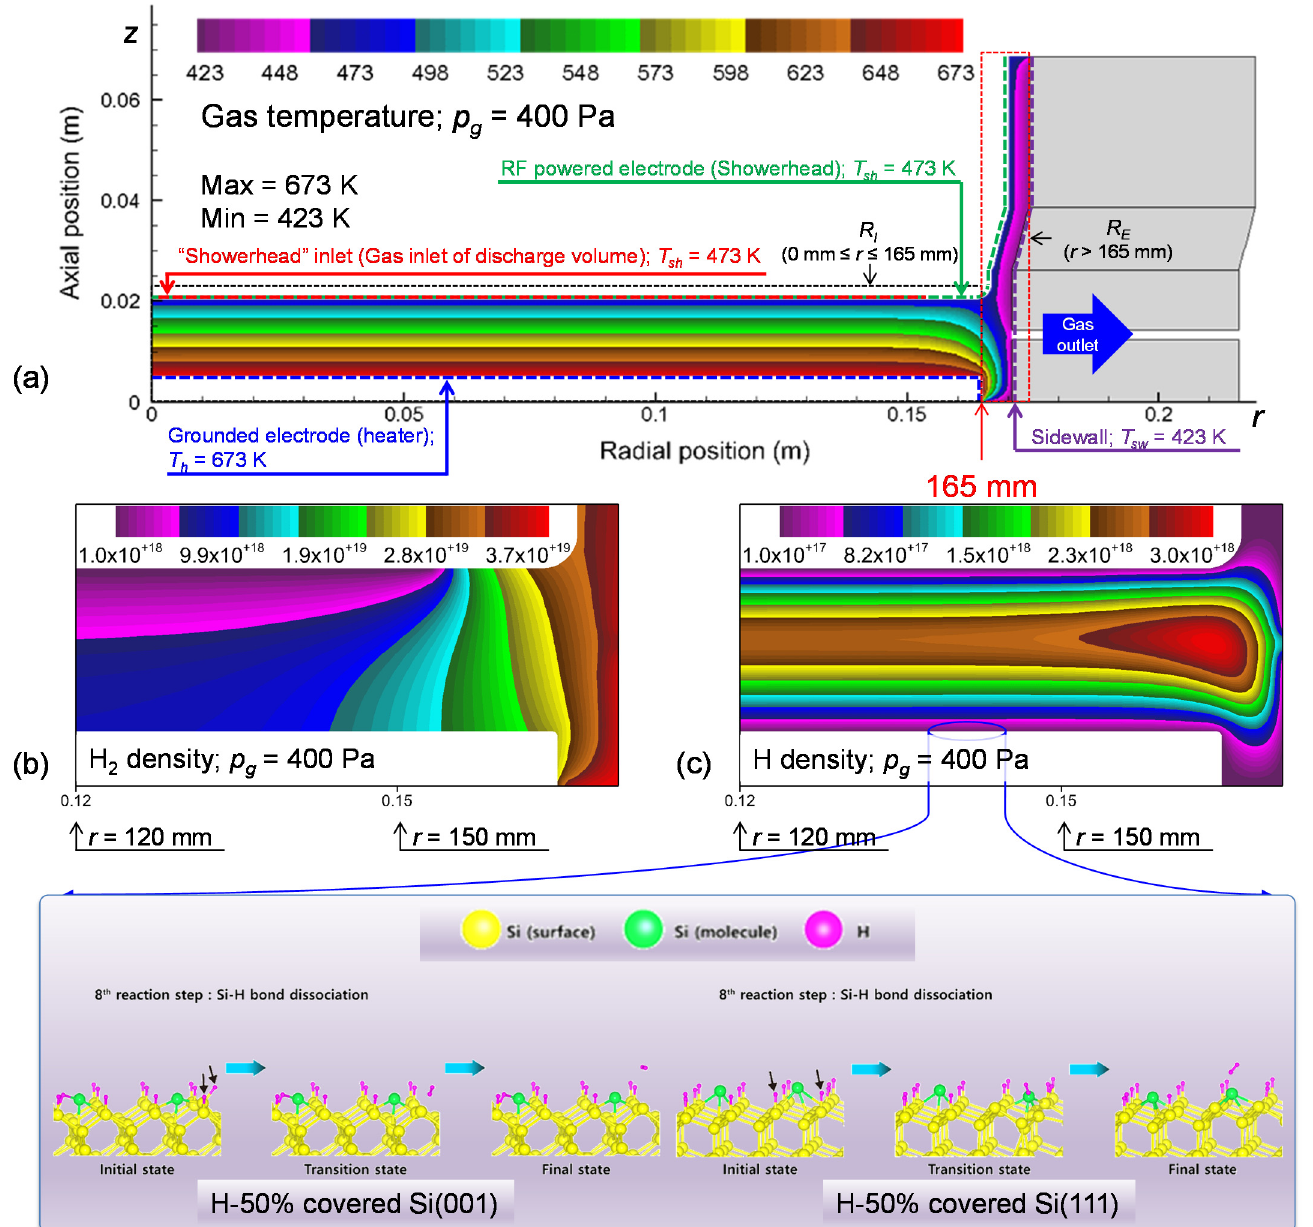
Figure 5. Schematic diagram of our reactor. ( a ) Spatial variation in the gas temperature ( T g , K). Contour plots of the spatial density profiles (m − 3 ) of ( b ) H 2 and ( c ) H for r ≥ 120 mm. Based on our DFT results, we modified the surface adsorption model.